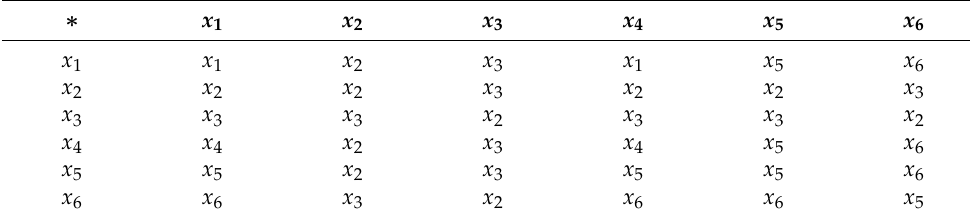
Table 12. A left transposition regular TA-root of band of Example